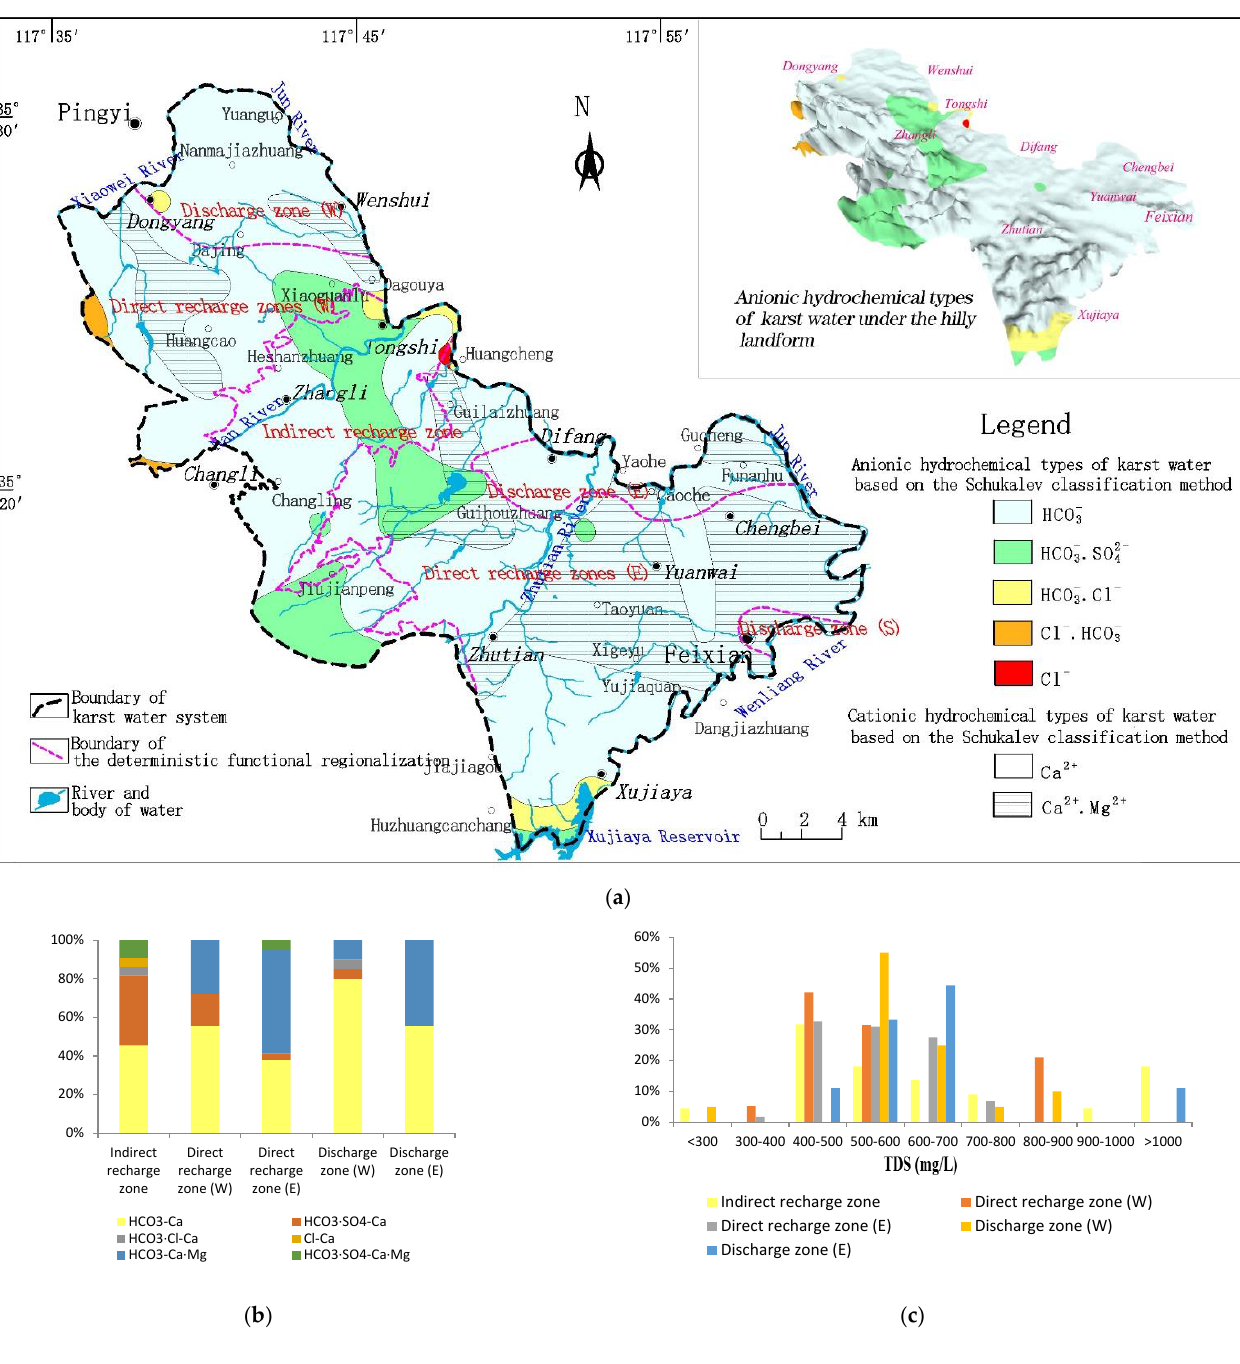
Figure 6. Distribution of hydrochemical types of karst water. ( a ) Zoning of the study region based on the hydrochemical types of karst water; ( b )The proportion of hydrochemical types in the total number of samples in each zone; ( c ) The proportion of TDS levels in the total number of samples in each zone.